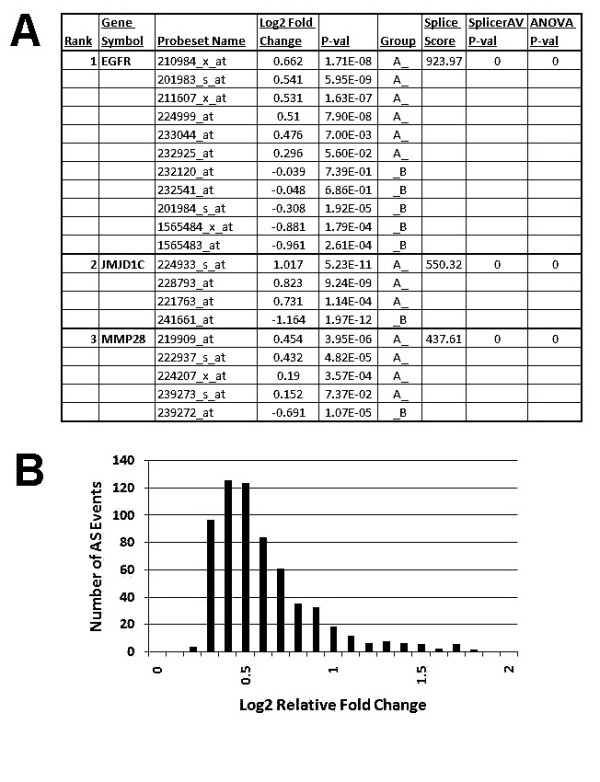
HRAS over-expression results in substantial relative isoform changes. (A) Example SplicerAV output comparing HRAS to GFP over-expression. Genes are ranked in order of descending Splice Score (top three genes shown), with EGFR receiving the top score in HRAS over-expression. Log2 fold change in expression and corresponding p-values from two tailed homoskedastic t-test of differential expression are shown for individual probesets targeting each gene. Probesets are placed into A and B groupings by SplicerAV (see text). Splice score, SplicerAV p-value, and two way ANOVA p-values are shown for each gene. (B) Distribution of the 645 isoform changes (AS Events) predicted by SplicerAV (p < .01) upon HRAS over-expression in human primary mammary epithelial cells. For each gene, SplicerAV separates probesets into two similarly behaving groups based on similar fold changes in expression. The average change in expression between probesets in these two groups (AvgChange, see Equation 8 in methods) reflects the relative fold change in isoform abundance predicted by SplicerAV. Absolute relative fold change in isoform abundance is shown in log base 2.